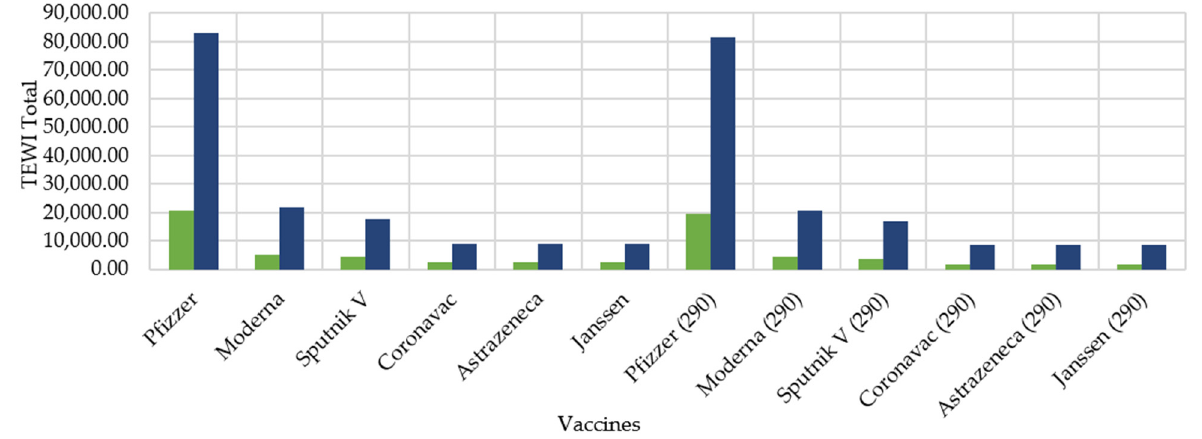
Figure 4. Comparison of total refrigerated TEWI values of 100,000 doses of vaccines in the United States and Brazil for 10 years. Caption: Brazil: (cid:4) ; USA: (cid:4) .